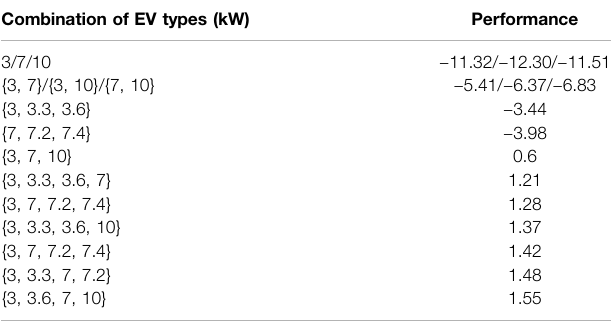
TABLE 2 | Classi fi cation effects of different combinations of EV types.